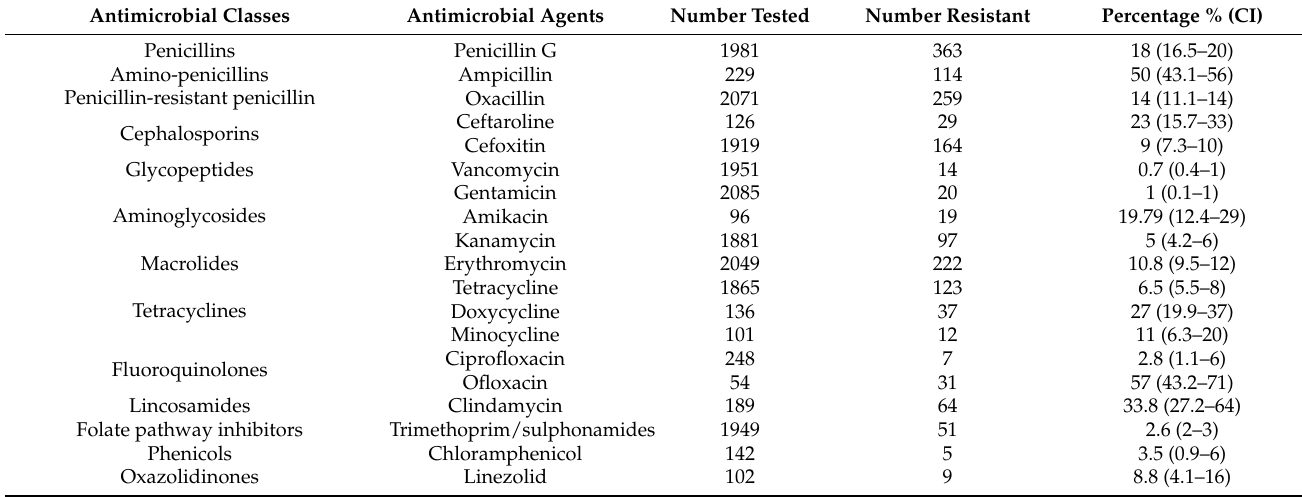
Table 5. Characteristics of antimicrobial resistance of S. aureus from meat and meat products in African countries. Antimicrobial Classes